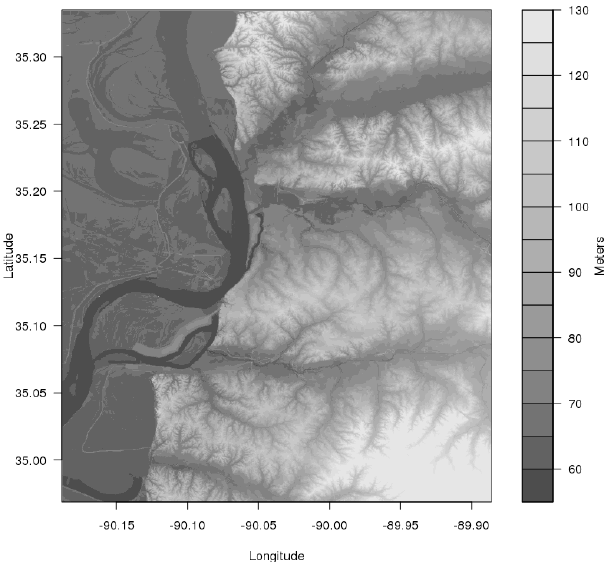
Figure 1: Digital Elevation Model for the region of study.